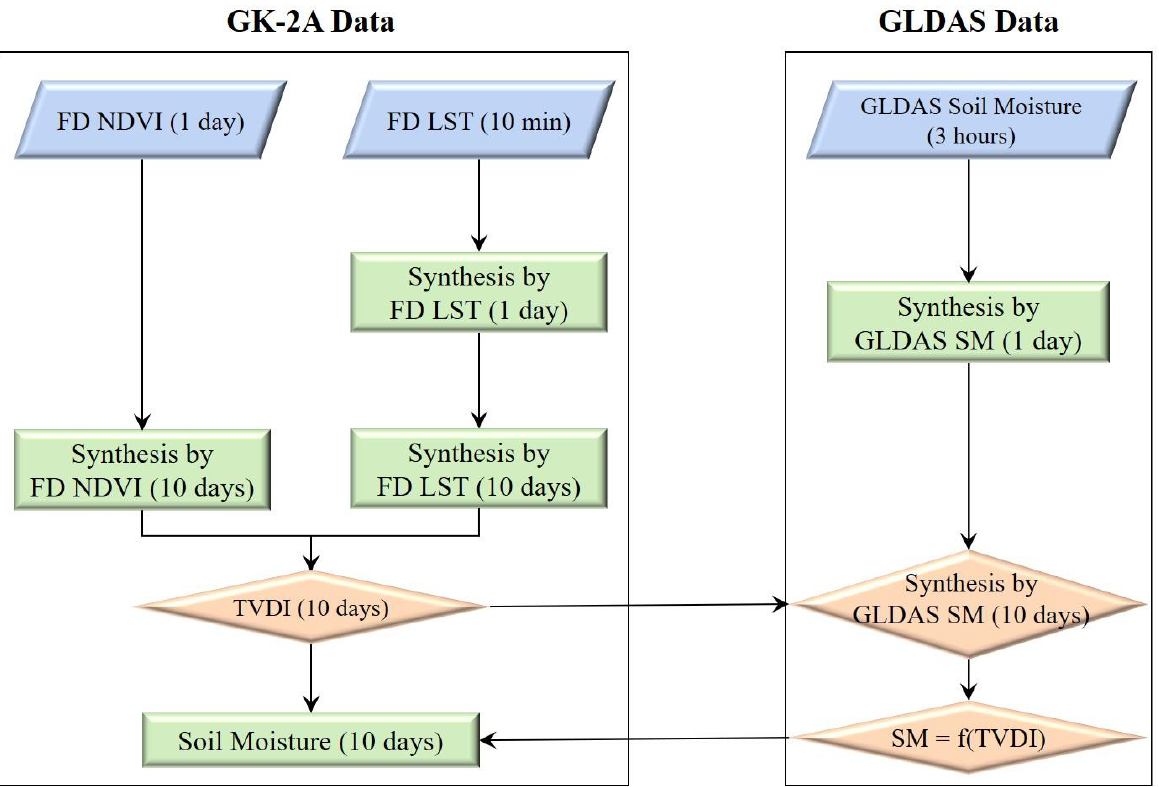
Figure 3. Flow chart of the GK-2A TVDI -based SM retrieval algorithm.